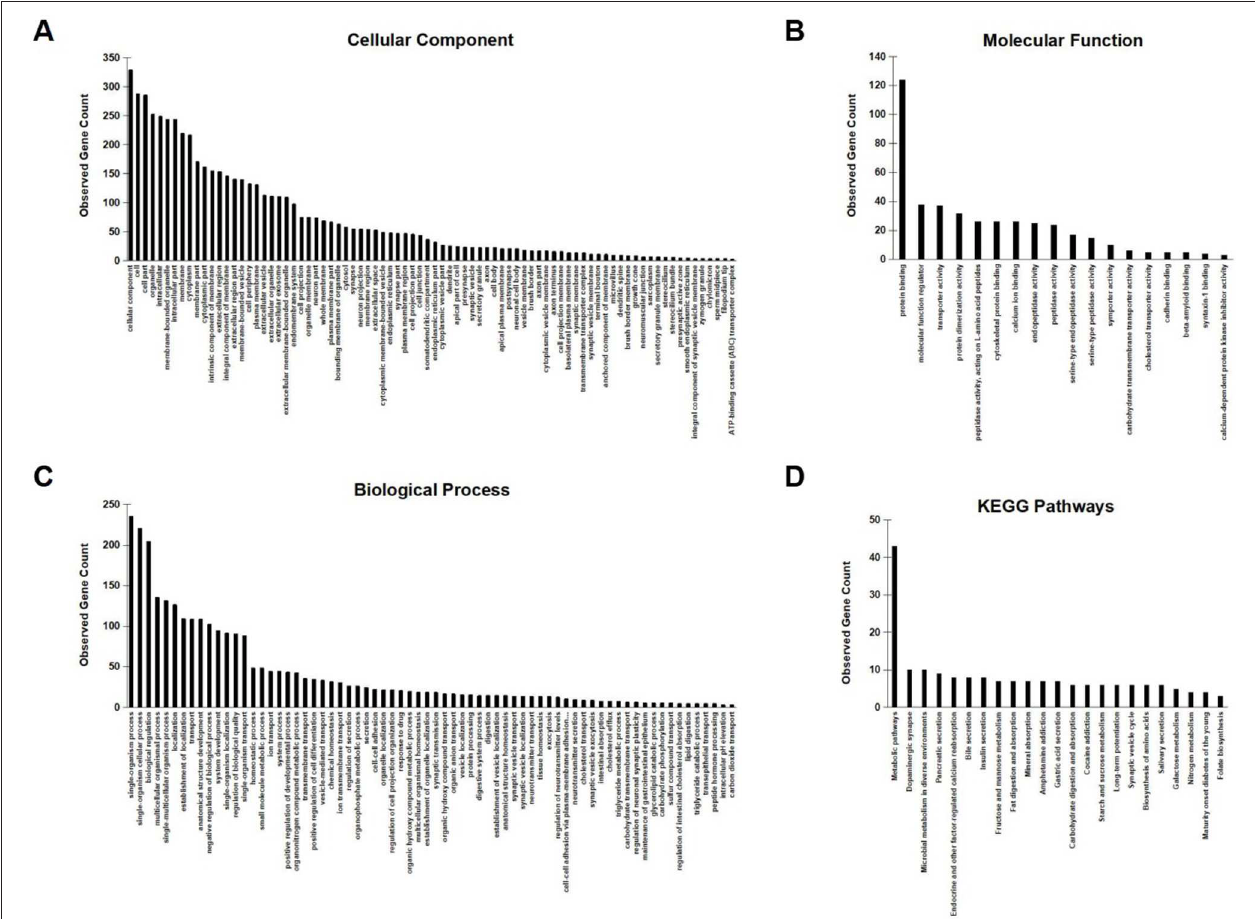
FIGURE 8 | GO enrichment analysis and KEGG signaling pathway analysis. (A–C) Observed gene counts for each GO term were shown. (D) KEGG analysis identified 23 molecular pathways and gene counts for each mathway were